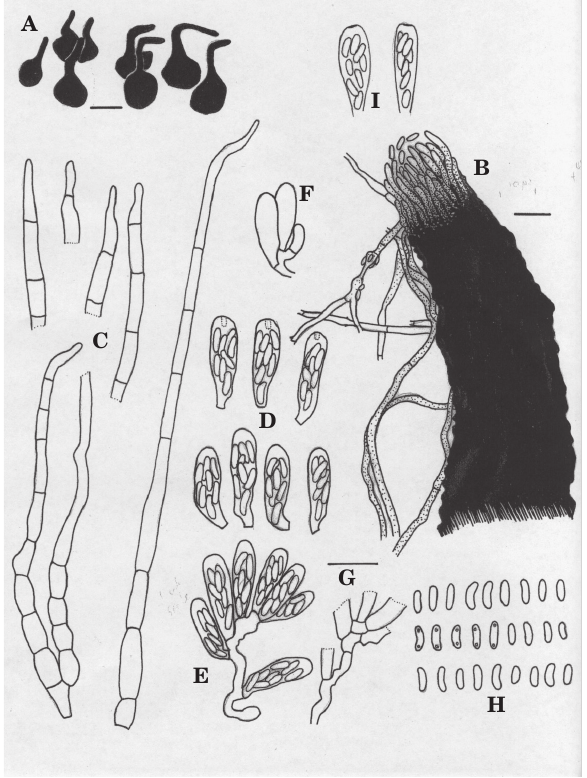
Fig. 3. Togninia minima teleomorph A. Ascomata. B. Ascoma neck with ostiolar hyphae, and hyphae and co- nidiophores of the Phaeoacremonium anamorph. C. Par- aphyses. D. Asci. E. Ascogenous hypha. F. Immature asci. G. Spent ascogenous hypha, with basal frills. H. As- cospores discharged from ascoma neck. I. Asci discharged from ascoma neck (scale bars 100 and 10